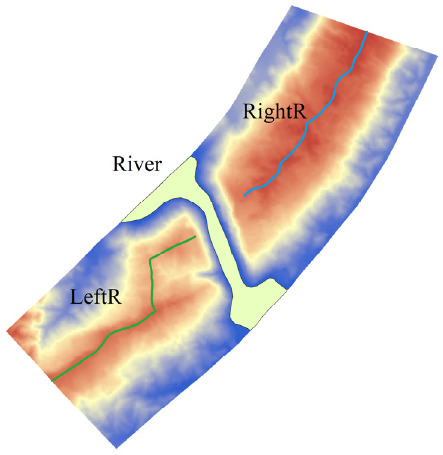
Figure 5. The ridgeline of the mountains on both sides of C4. LeftR is the ridgeline of the left mountain, and RightR is the ridgeline of the right mountain.